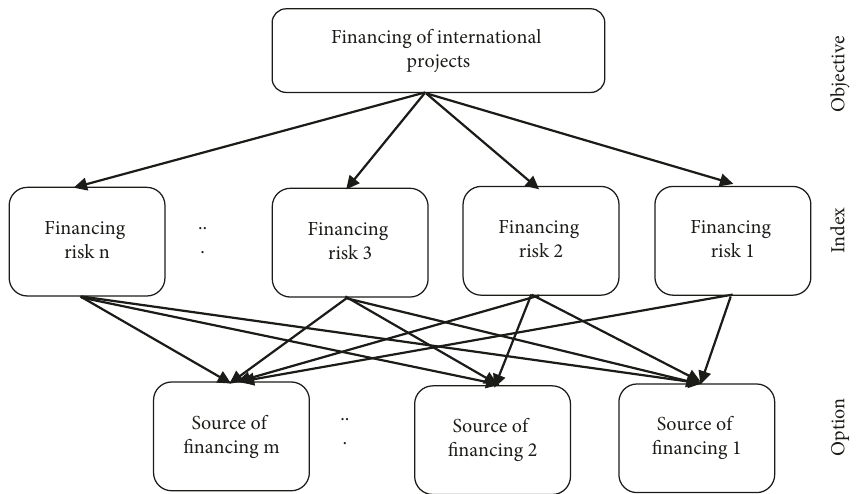
Figure 1: Conceptual model of hierarchical analysis of financing international projects.